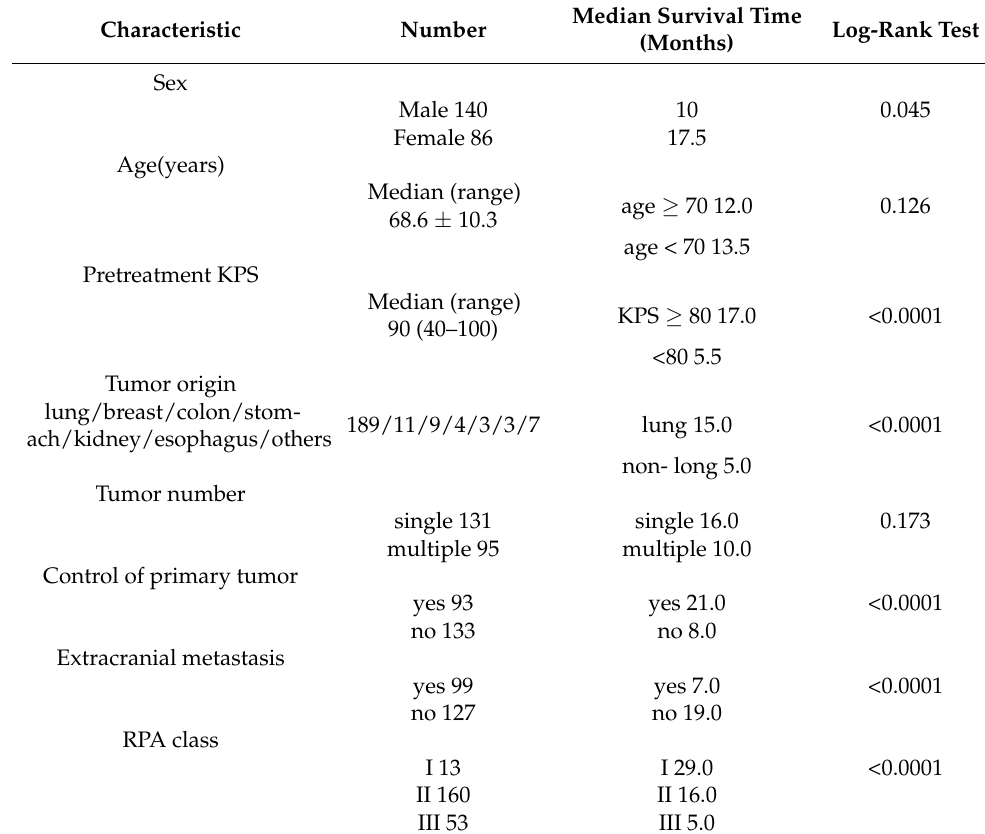
Table 1. Characteristics of patients with brain metastases and